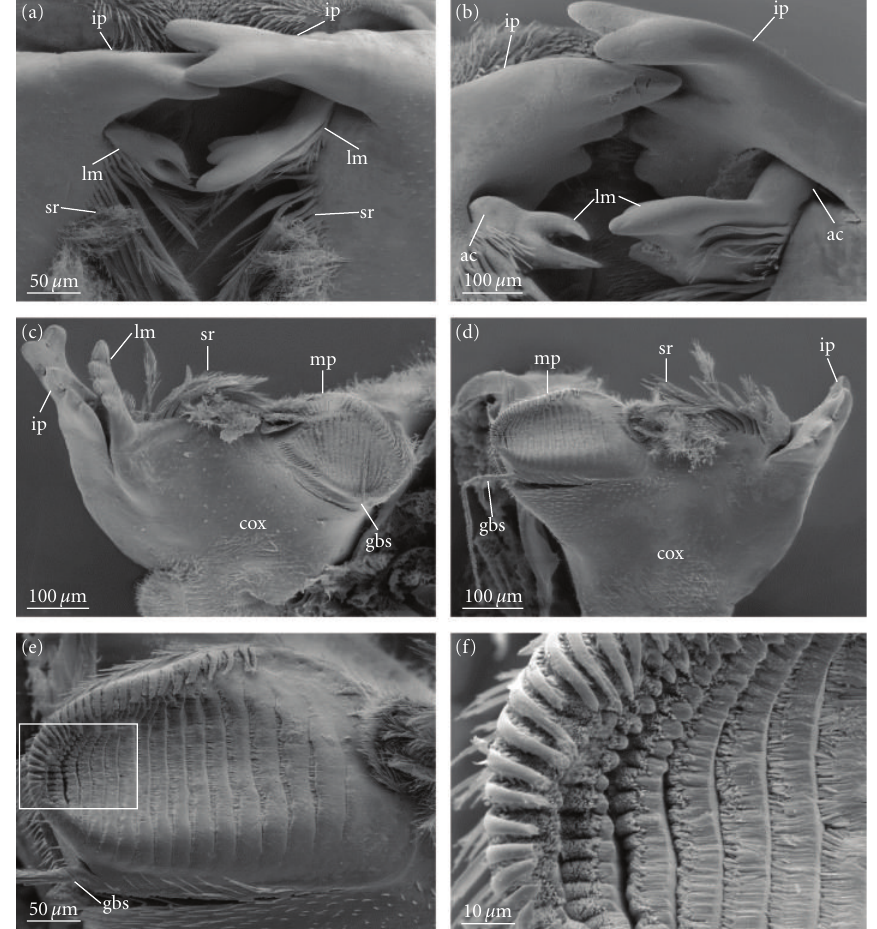
Figure 15: SEM images of mandibles of Gammarus fossarum : (a) incisor processes, lacinia mobiles, and setal rows of mandibles in situ in posterior view; (b) incisor processes and lacinia mobiles of mandibles in situ in posterodorsal view; (c) coxa of left mandible in anterior view; (d) coxa of right mandible in anterior view; (e) molar of right mandible in medioanterior view, rectangle indicates close-up image in (f); (f) closeup of molar surface of right mandible in median view (cf. (e)). Abbreviations other than in previous figures: ac, articular